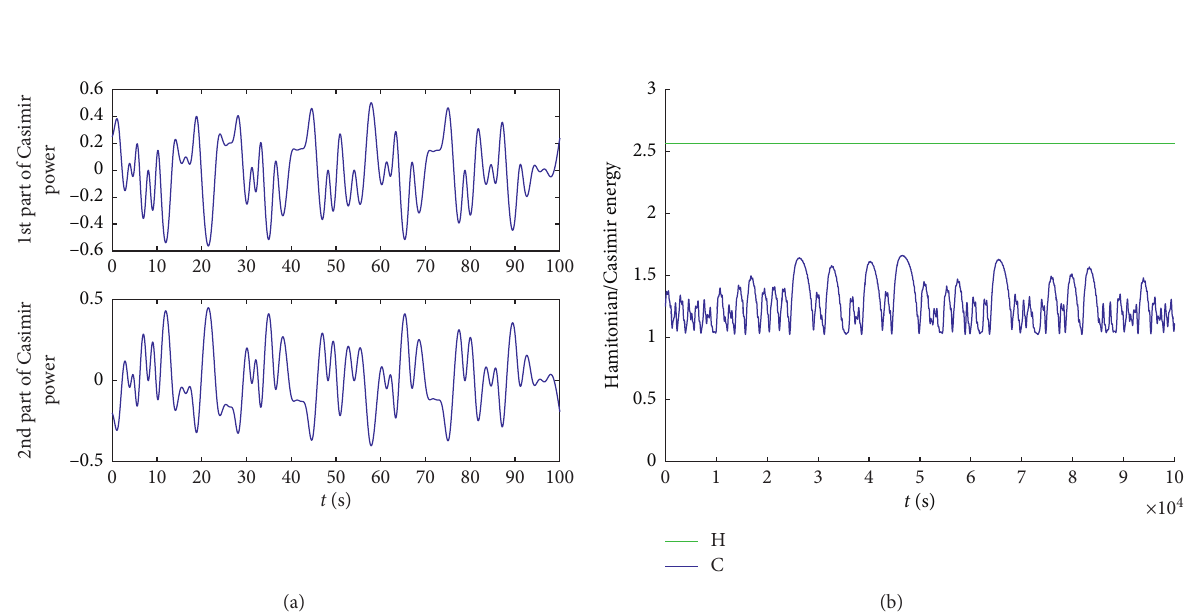
Figure 1: Casimir power, Hamilton energy, and Casimir energy of Case 1 system. (a) Two parts of Casimir powers. (b) Hamilton energy and Casimir energy.